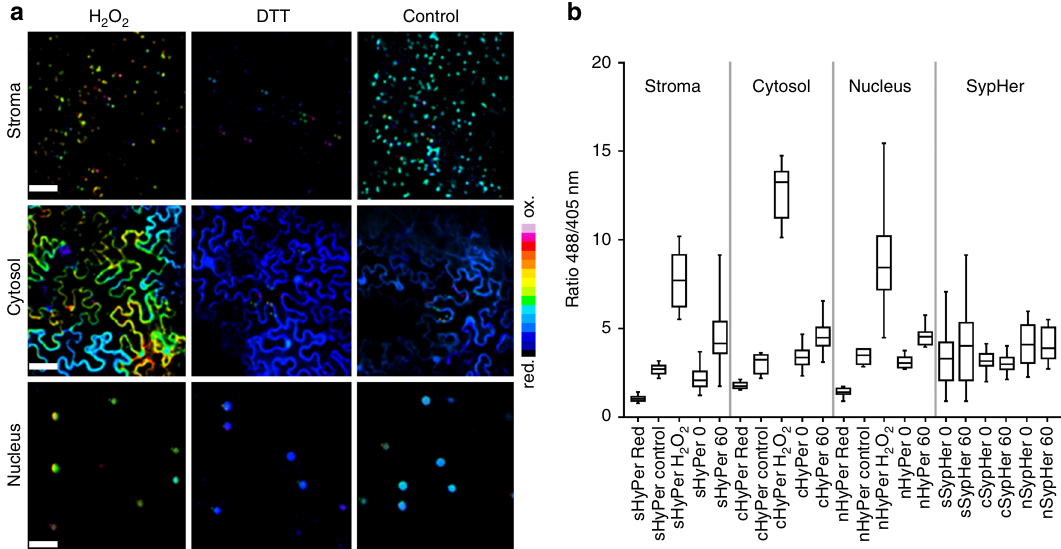
Fig. 1 HyPer2 responds to hydrogen peroxide and dithiothreitol as well as high light in different subcellular compartments of Nicotiana benthamiana epidermal cells. a Ratiometric images (F488/405nm) of fl uorescence emission at 530 nm following excitation at 488 and 405 nm showing oxidised state (10 mM H 2 O 2 for 20 mins), reduced state (10 mM DTT for 20 mins) and resting state (Control) of stromal, cytosolic and nuclear targeted HyPer2 respectively. Oxidation of HyPer2 increases the 488/405nm ratio. b Comparison of the response of HyPer2 and SypHer to reduction by DTT, oxidation by H 2 O 2 and exposure to 60 min HL (1000 µ mol m − 2 s − 1 ) and at the start (0 min; GL conditions). Scale bar = 50 µ m. Error bars represent the SD, n = 11